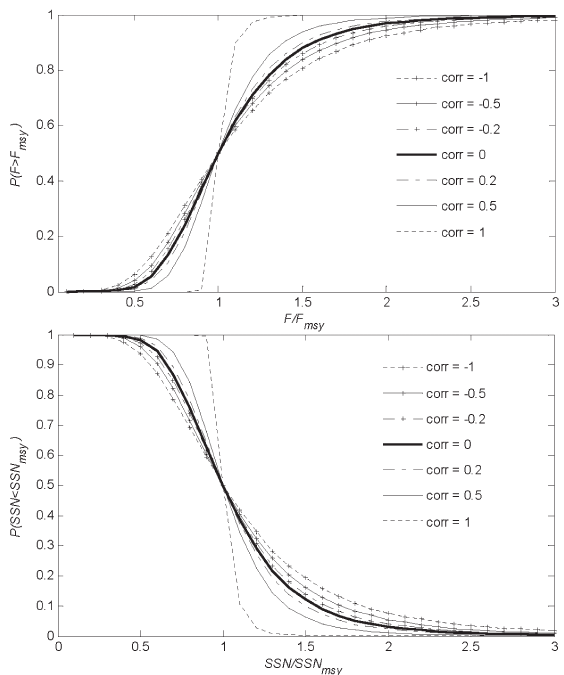
Fig . 8. – Risk of using different target fishing mortalities and N in the designed control rule. To illustrate the influence of cor- old relations between indicators, correlation coefficients between F and F , and between SSN and SSN vary from -1 to 1. Uncertainty msy msy (CVs here) of F and SSN are from the walleye fishery example. msy msy